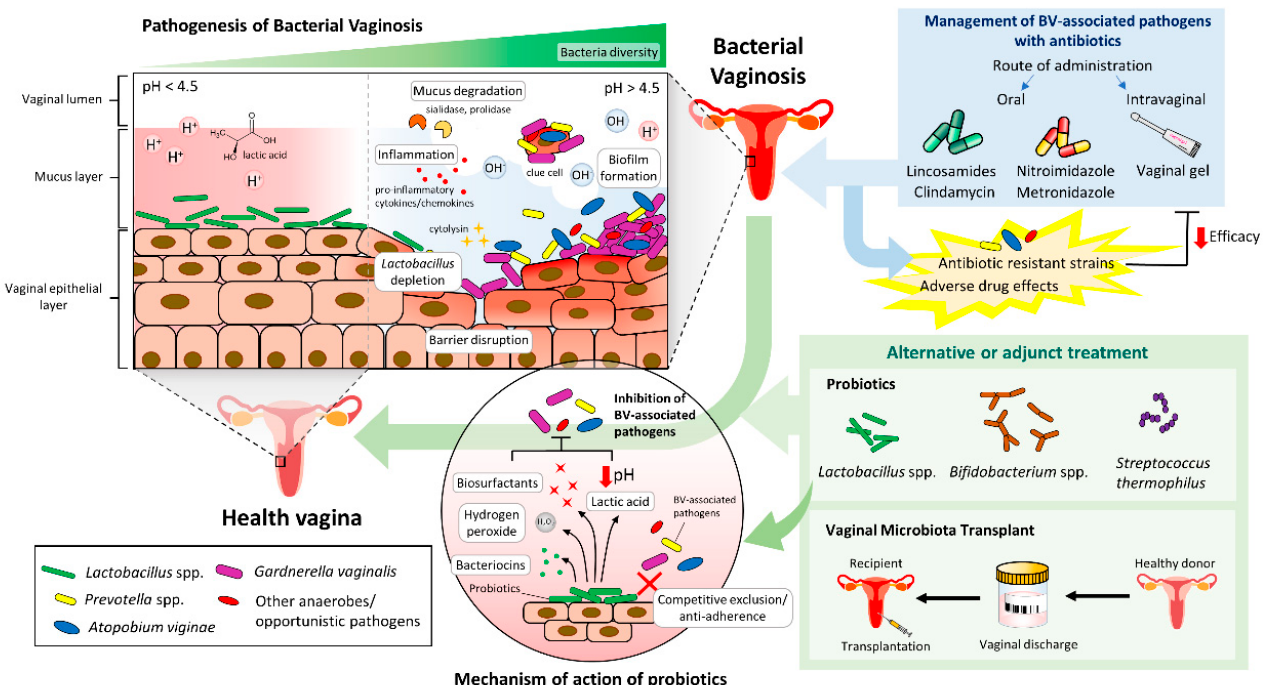
Figure 1. Pathogenesis of bacterial vaginosis (BV) and the mechanism of action of probiotics in battling against BV.